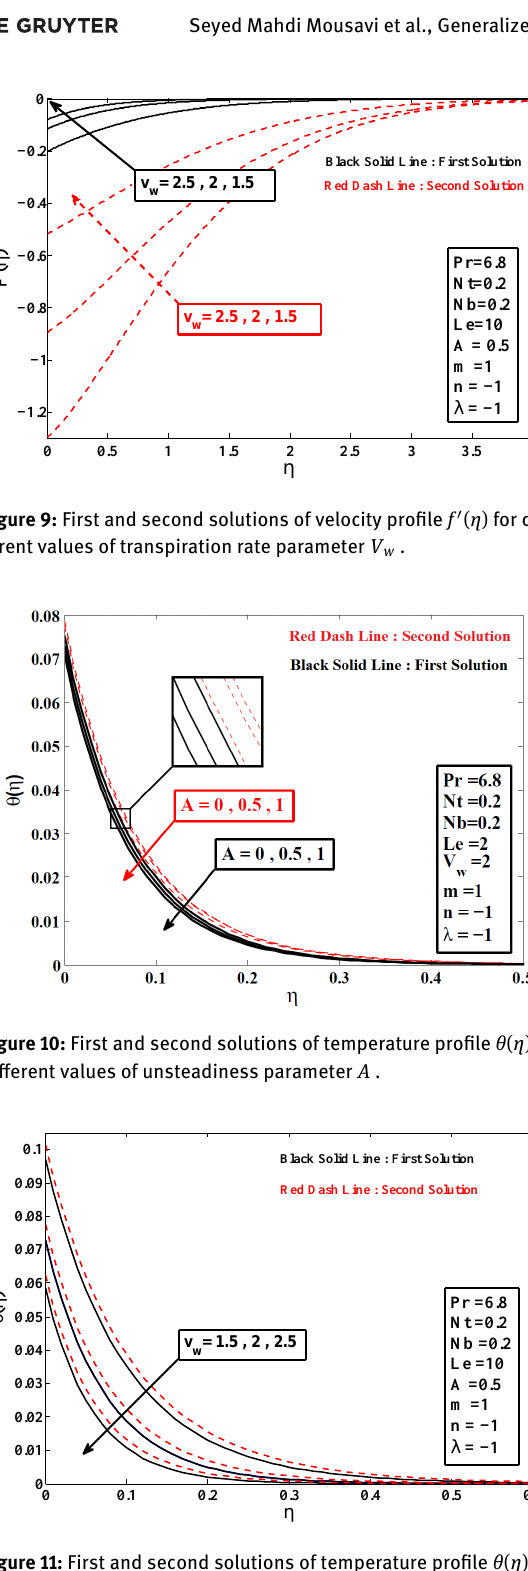
Figure 11: First and second solutions of temperature profile θ ( η ) for different values of transpiration rate parameter V w .